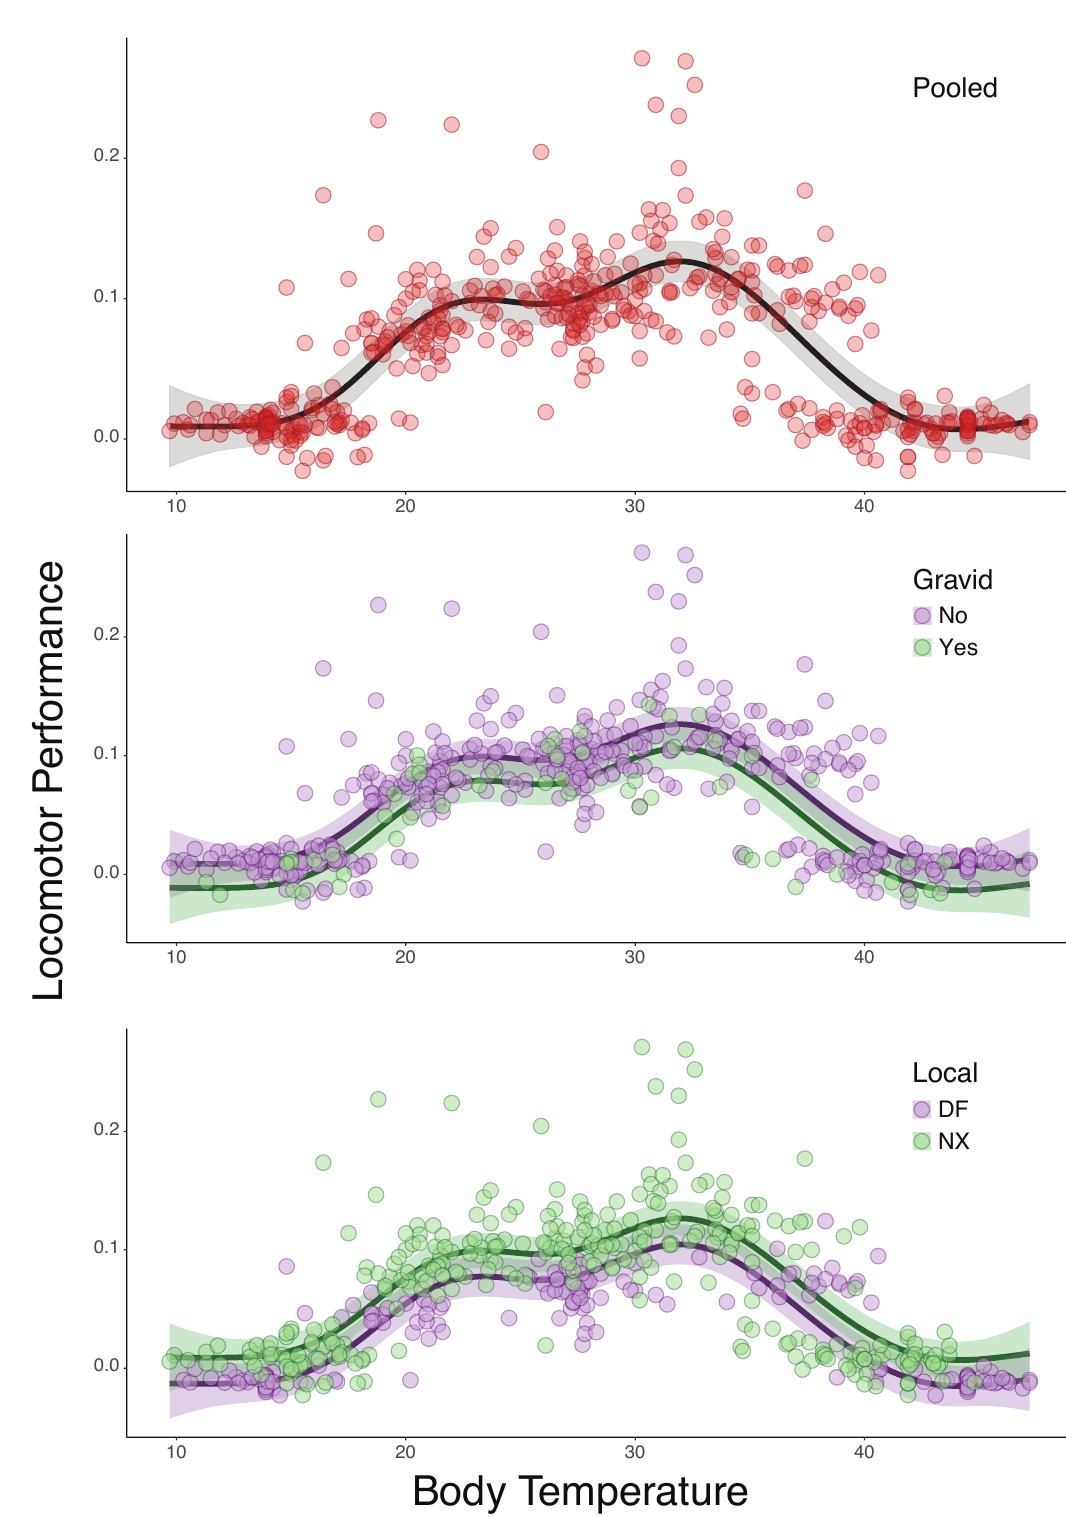
Figure 1. Locomotor performance (sprint speed) of the lizard Micrablepharus atticolus as a function of ( A ) body temperature, ( B ) body temperature and female reproductive condition (gravid females vs. non-gravid females and males), and ( C ) body temperature and geography. Points represent partial residuals of a generalized additive mixed model (GAMM), while lines and bands represent the predictions and confidence limits,